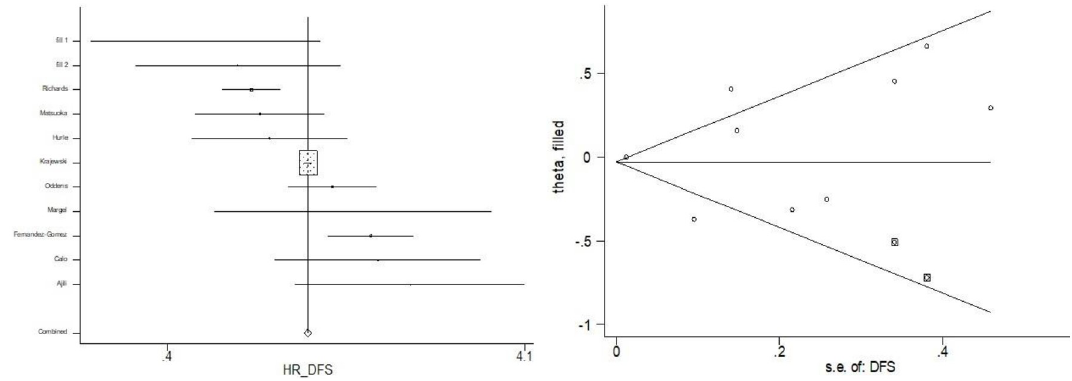
Fig 7. Publication bias for two missing